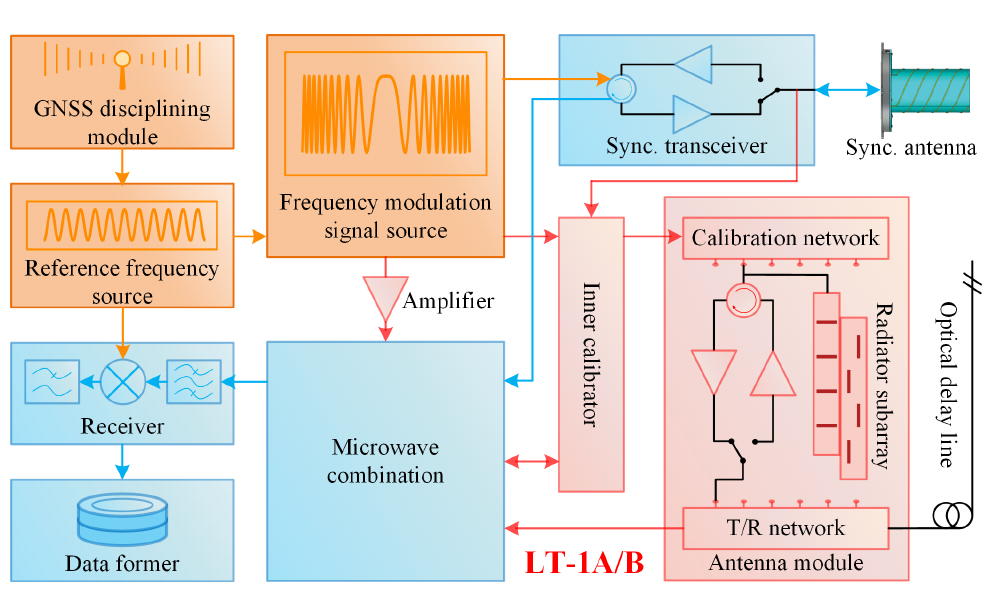
Figure 3. Structure block diagram the LT-1